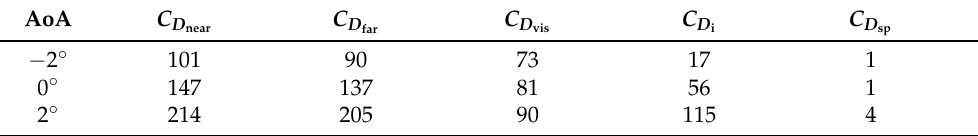
Table 8. OFF configuration (fine mesh level) at Re ∞ = 16.6 × 10 6 , M ∞ = 0.480. Breakdown of the drag polars with spurious drag detection; induced drag computed by Maskell’s formula. AoA